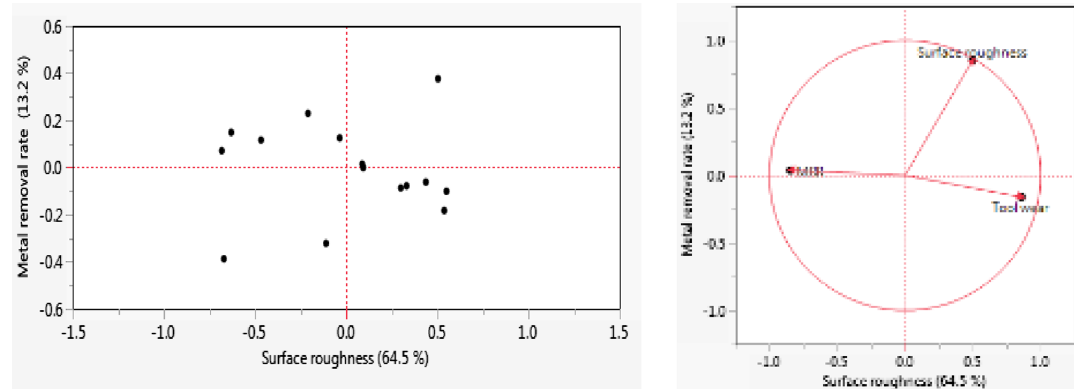
Fig.8 Accountability proportion (AP) values of surface roughness vs. metal removal rate